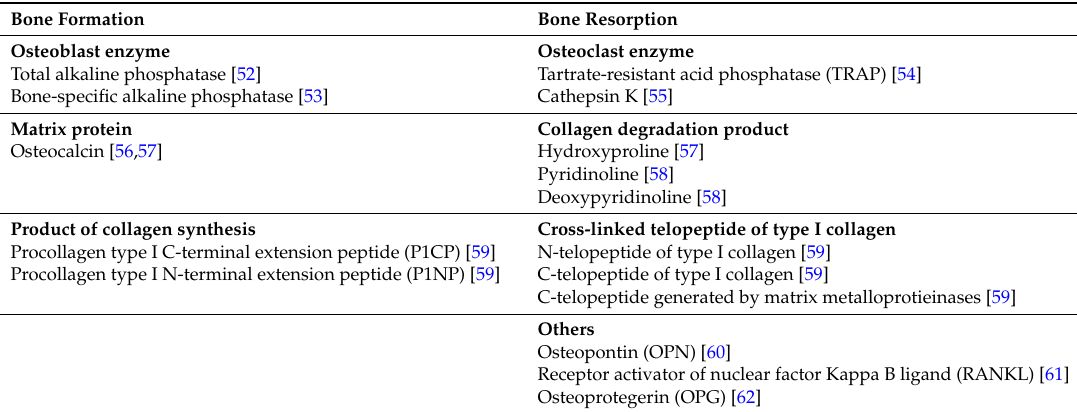
Table 1. Commonly used biomarkers of bone